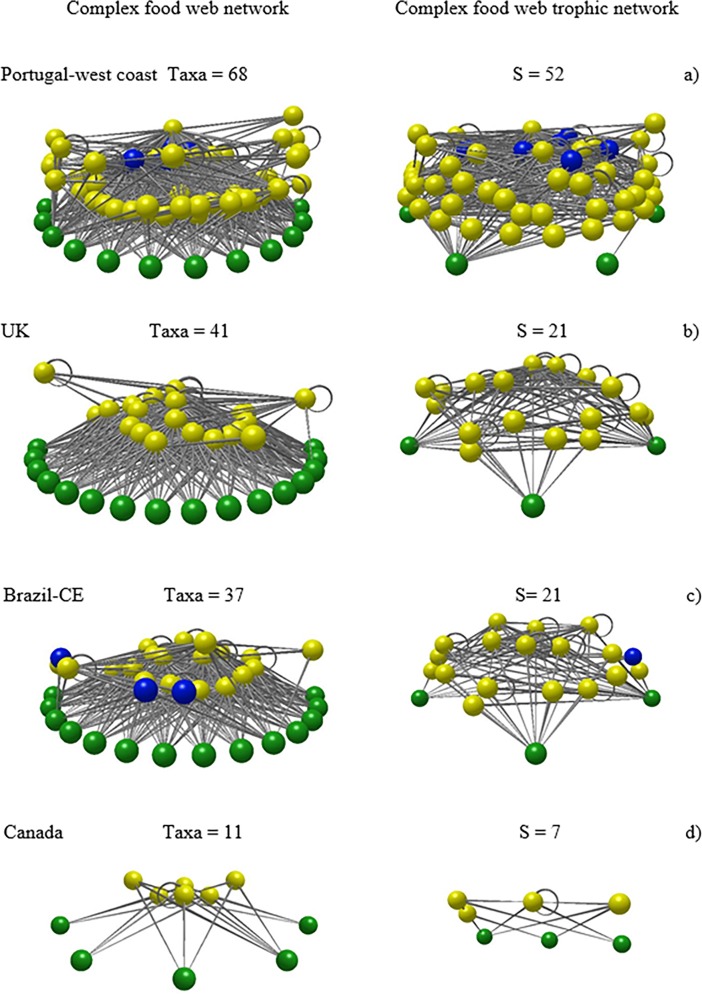
Network3D images of food web networks of selected rock intertidal pools.a–food web with the highest S, b and c–food webs with average S, d–food web in the lowest S. Green nodes = basal taxa; yellow nodes = invertebrates; blue nodes = vertebrates). On the left complex food web networks are depicted, on the right are the trophic species versions of the same food webs. Trophic species are groups of taxa whose members share the same set of predators and prey and are thus aggregated in single nodes.